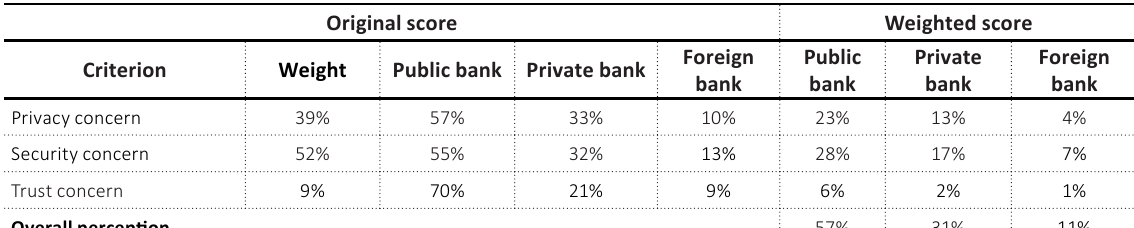
Table 11. E-banking users’ perception for various types of banks based on weighted score of selected